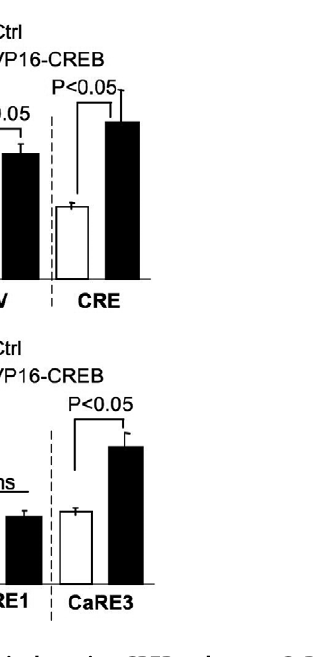
Figure 8. Constitutively active CREB enhances CaRE3 but not CaRE1 activity. (A) Promoter IV- or CRE-luciferase reporter construct was co-transfected with TK-pRL and VP16-CREB expression plasmid into DIV 9 neurons. (B) CaRE1- or CaRE3-luciferase reporter construct was co- transfected with TK-pRL and VP16-CREB expression plasmid into DIV 9 neurons. The activity of promoter IV, CRE, CaRE1, and CaRE3 was determined by dual luciferase assay on DIV 11. After normalized to Renilla luciferase activity, CRE, or CaRE1 or CaRE3 activity was further normalized to SV40 activity in neurons transfected with SV40-luciferase, TK-pRL, and VP16-CREB. ns: not statistically significant. Data were collected from 5 independent preparations for each treatment.